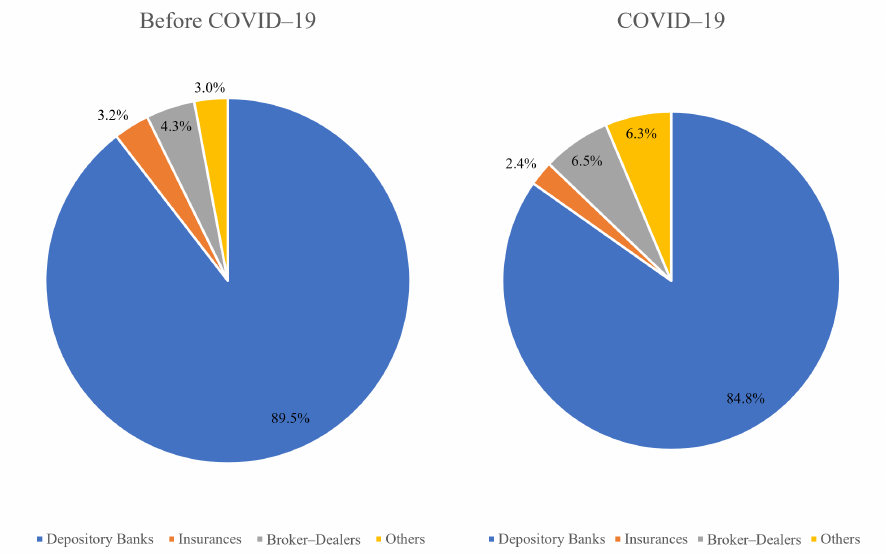
Figure 3. Value of CES% contribution for four groups of financial institutions before and dur- ing COVID-19.